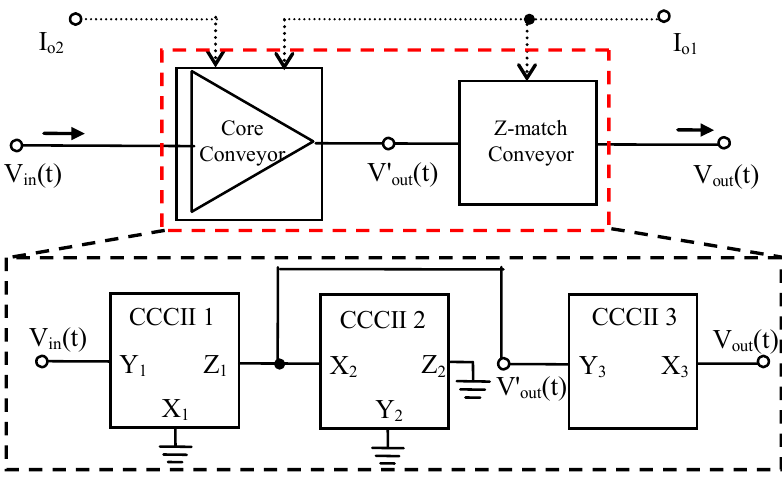
Figure 2. The operational principle of CCCII-based LNA.